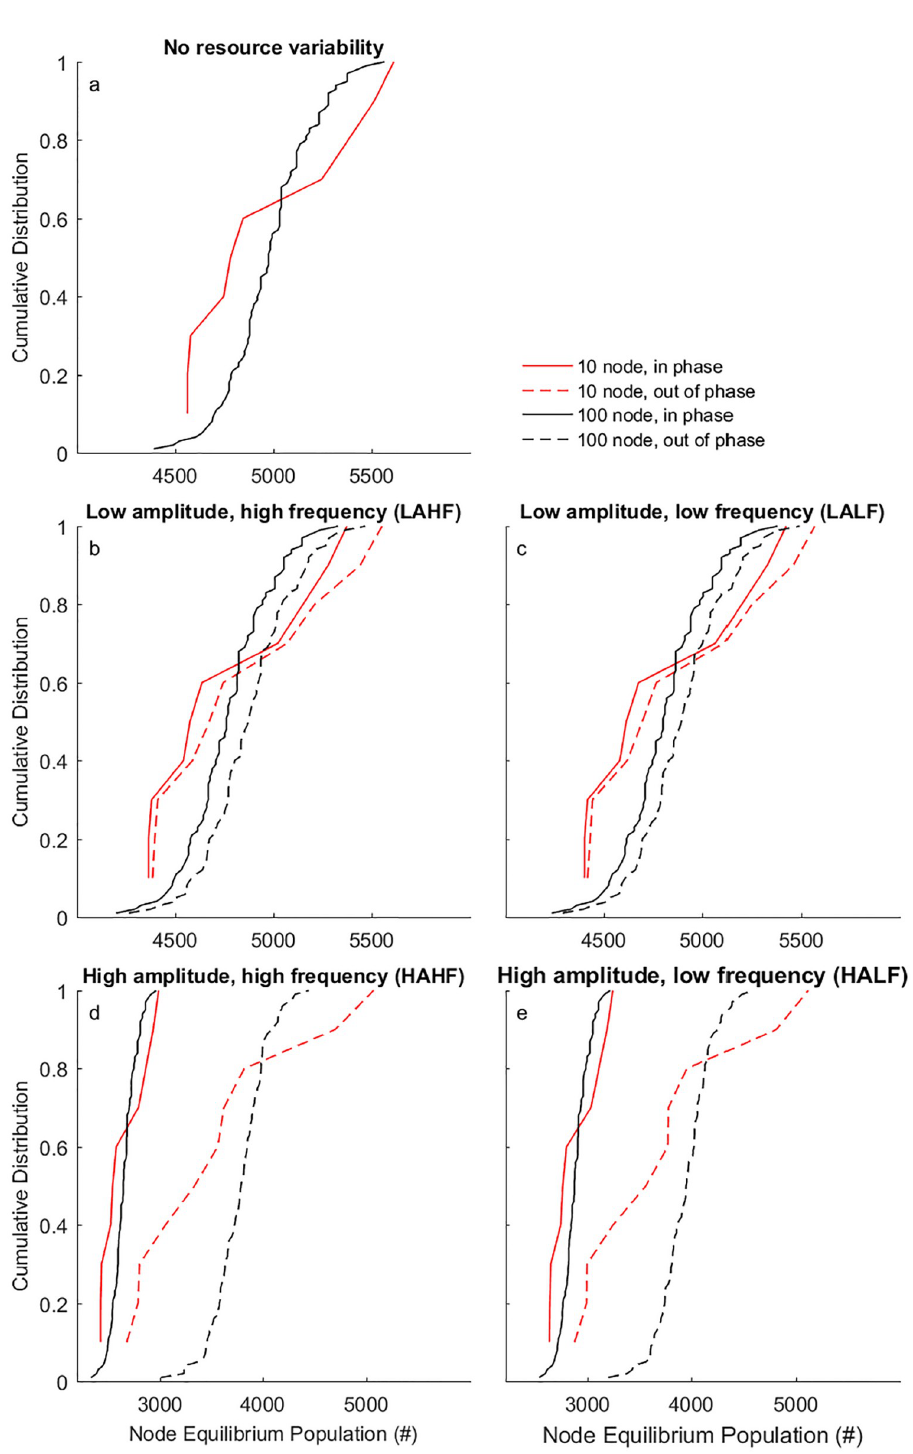
Fig 2. The cumulative distribution of NEP in the 10 and 100 node networks under the variability scenarios. (A) Cumulative distribution of NEP in the 10 node and 100 node networks. The cumulative fraction (y-axis) shows the proportion of nodes with a value less than or equal to the associated X value. (B,C,D,E) Effect of resource variability on NEP distributions within the networks. Solid lines indicate in phase resource variability. Dashed lines indicate 180 degrees out of phase resource